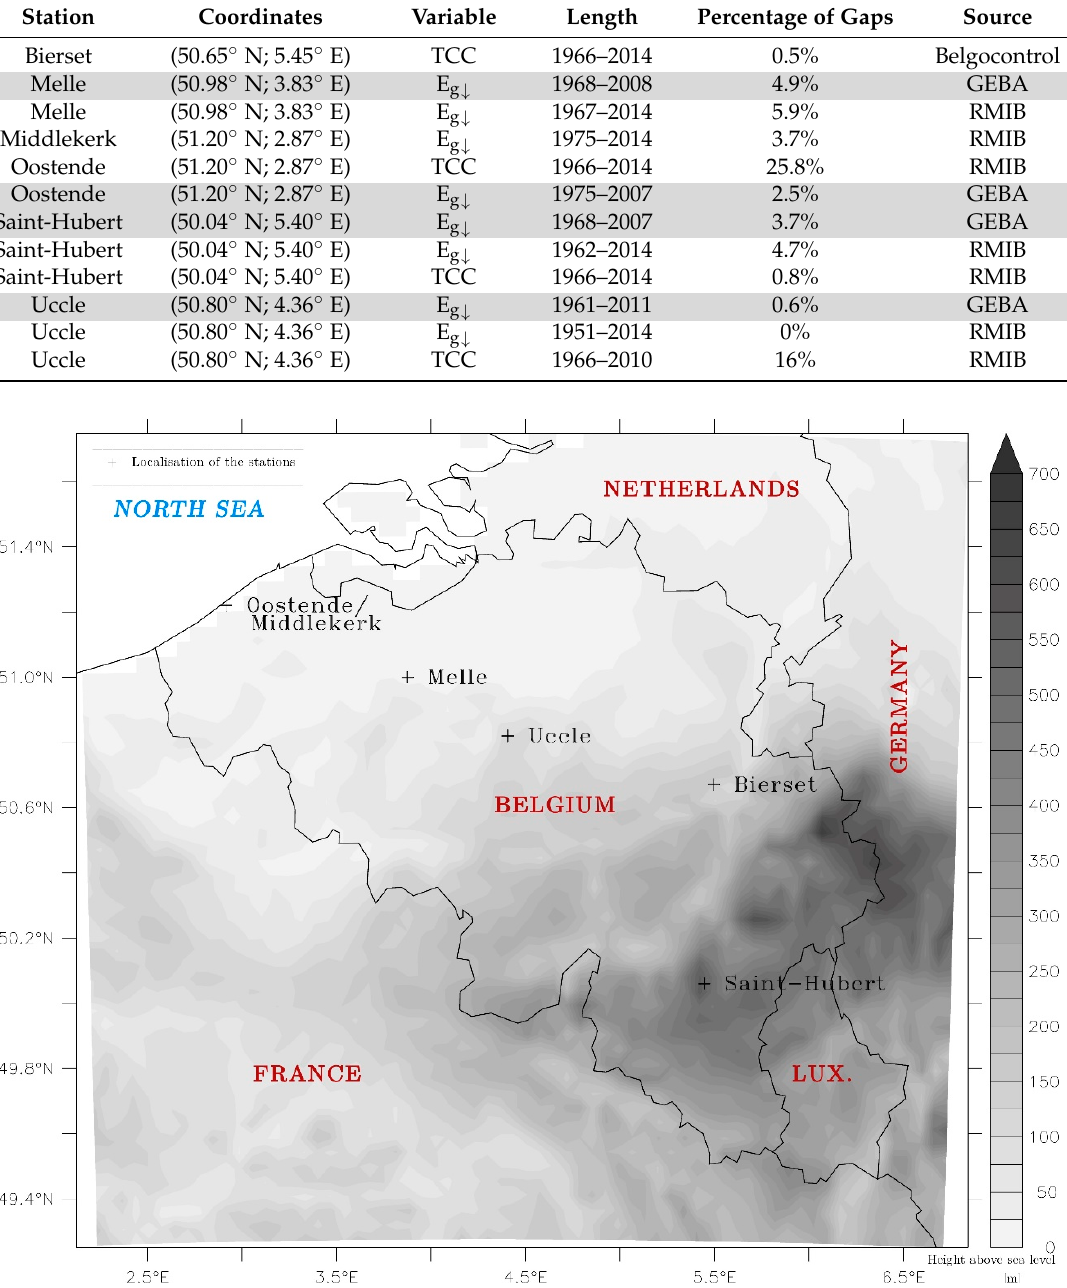
Table 1. Available E g ↓ and total cloud cover (TCC) time series of more than 30 years for Belgium. The percentage of gaps in the monthly data is also indicated. The time-series that were not selected as reference datasets for the evaluation of the Modèle Atmosphérique Régional (MAR) outputs and the reanalysis products have a grey background. GEBA: Global Energy Balance Archive; RMIB: Royal Meteorological Institute of Belgium.